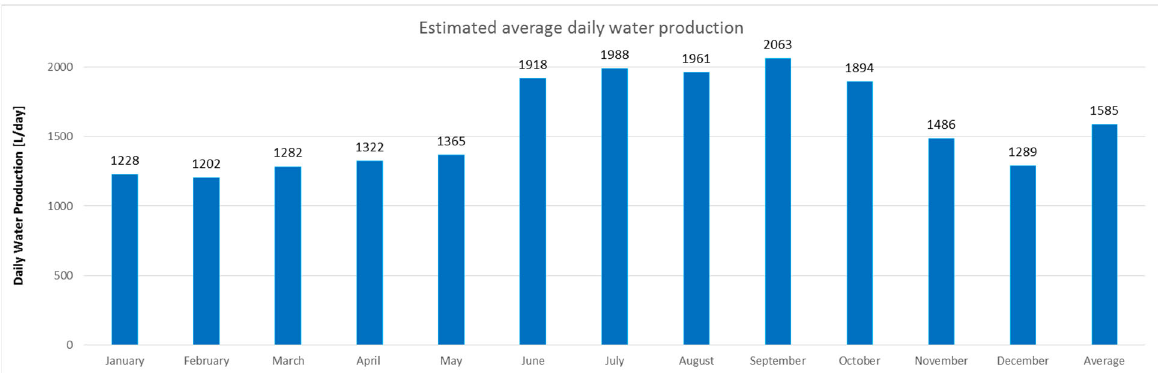
Figure 8. WET indicator: comparison between values coming, respectively, from real and simulated data.